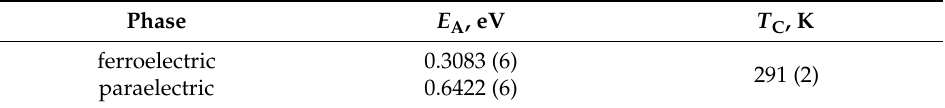
Table 2. Parameters of Equation (2) fitted to temperature dependence of dark current flowing through SbSI nanowires, as shown in Figure 4b, in vacuum ( p = 10 − 3 Pa). Phase